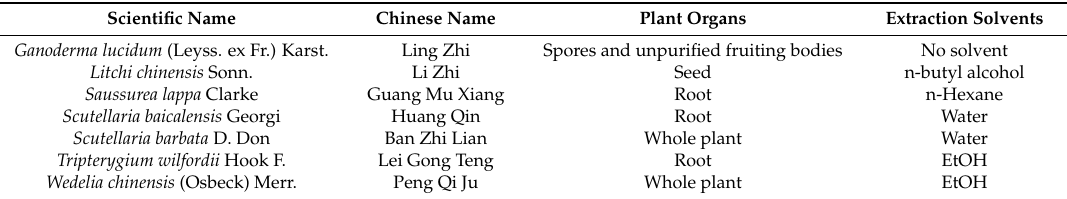
Table 1. Chinese medicine extracts inhibit prostate